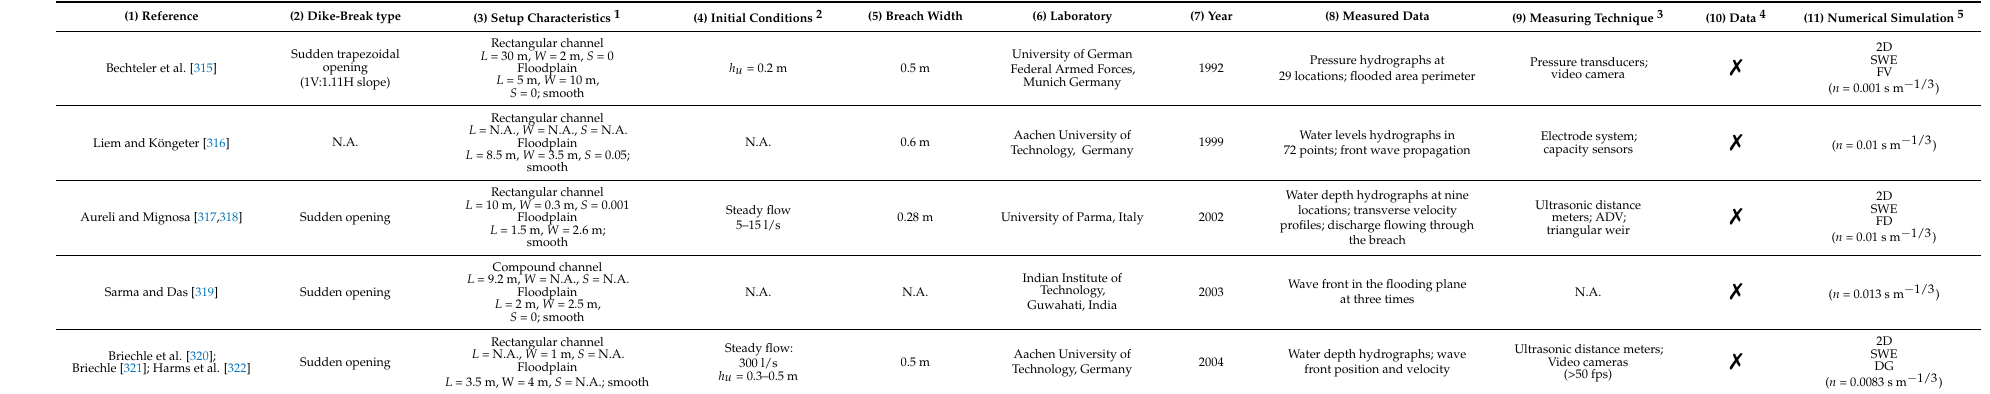
Table 9. Experimental investigations of dike-break induced flows on a lateral floodplain.